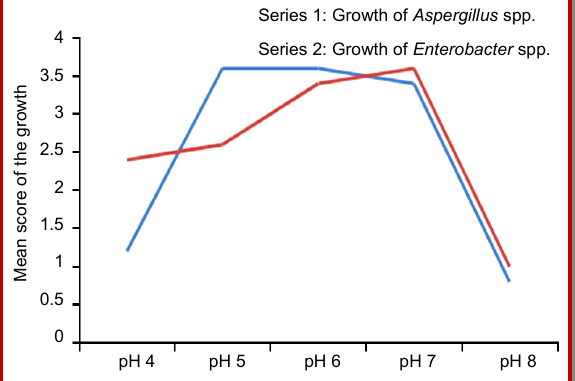
Figure 3: Diagram showing the inhibition of the growth of Asper- gillus spp. and Enterobacter spp. by clotrimazole (30 µg/mL) and tetracycline (50 µg/mL) at pH-adjusted potato dextrose agar media and MacConkey agar media respectively